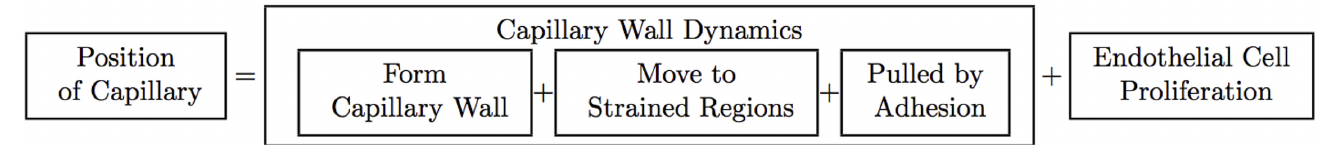
Fig 1. Representation of the terms included in Eq (1). The evolution of the order parameter depends on two processes: the endothelial cell proliferation and the movement of endothelial cells of the capillary on the ECM. The latter results from three main mechanisms that are implemented in our phase-field model. First, the constitution of a capillary wall (cells resist being isolated and leaving the vessel); we model this term as a surface tension. Second, the endothelial cells occupy regions of stiff tissue with high strains; this term is proportional to the difference between the tissue rigidities, but also proportional to the the local strain. Finally the cells can be pulled by the adhesion